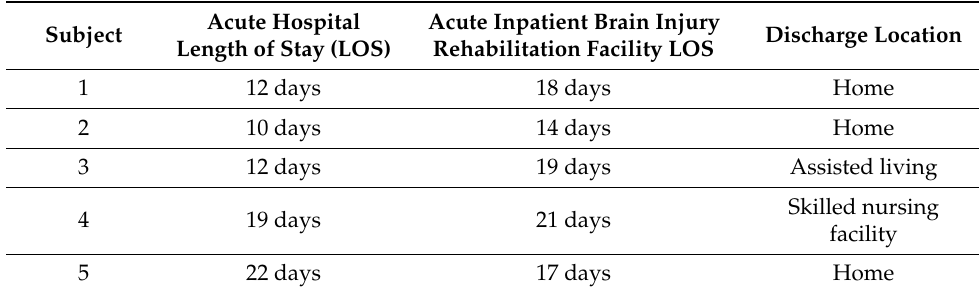
Table 2. Length of stay and disposition